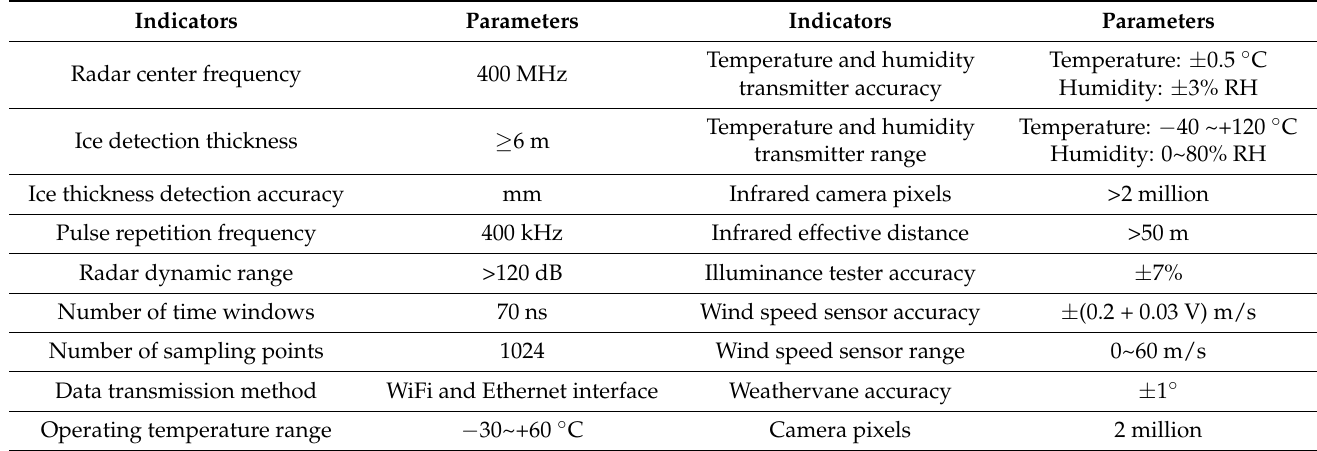
Table 1. Parameters of GPR ice monitoring